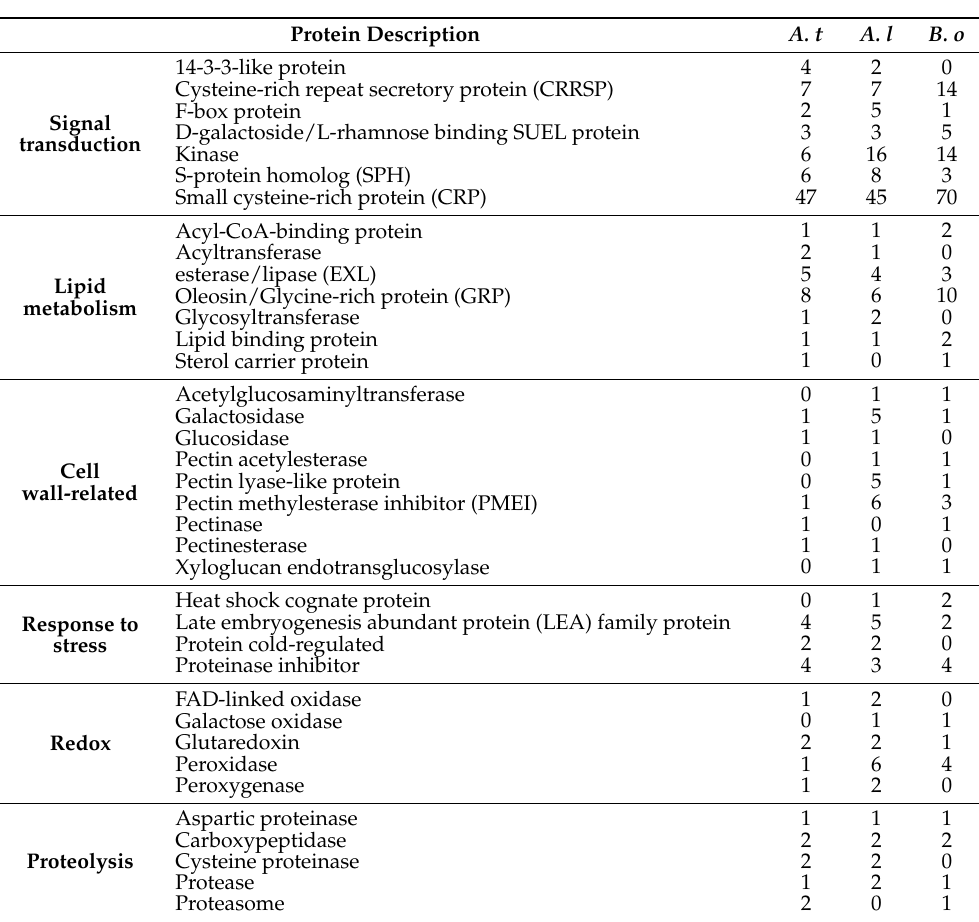
Table 1. Categories of protein families identified in the pollen coat from A. thaliana (A. t) , A. lyrata (A. l) , and B. oleracea (B. o)